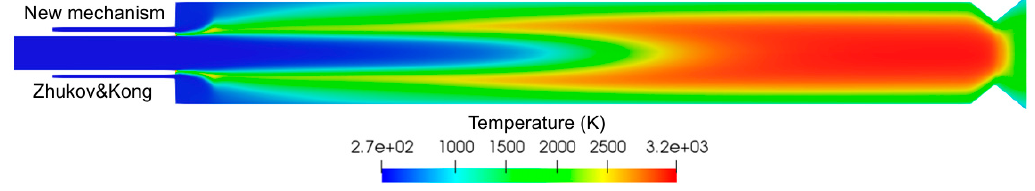
Figure 19. Computational fluid dynamic (CFD) simulations of a single-injector rocket combustor using flamelets generated with two different kinetic mechanisms [68,74].